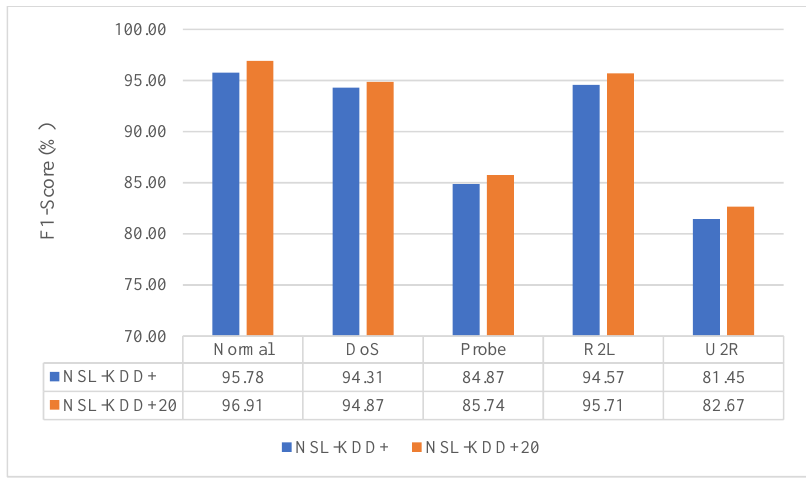
Figure 5. Specificity rate of different classes on NSL-KDD+ and NSL-KDD+20 datasets.